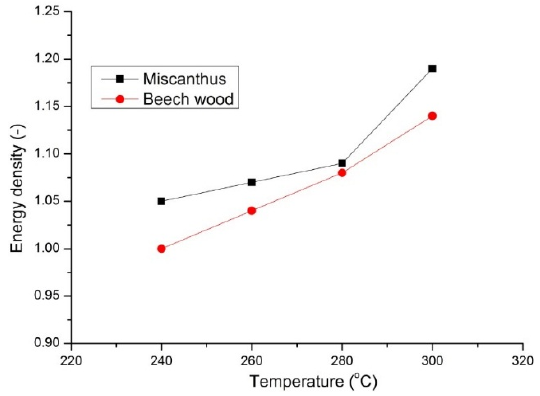
Figure 10. Effect of torrefaction temperature on the energy density of beech wood and miscanthus for residence time of 30 min.